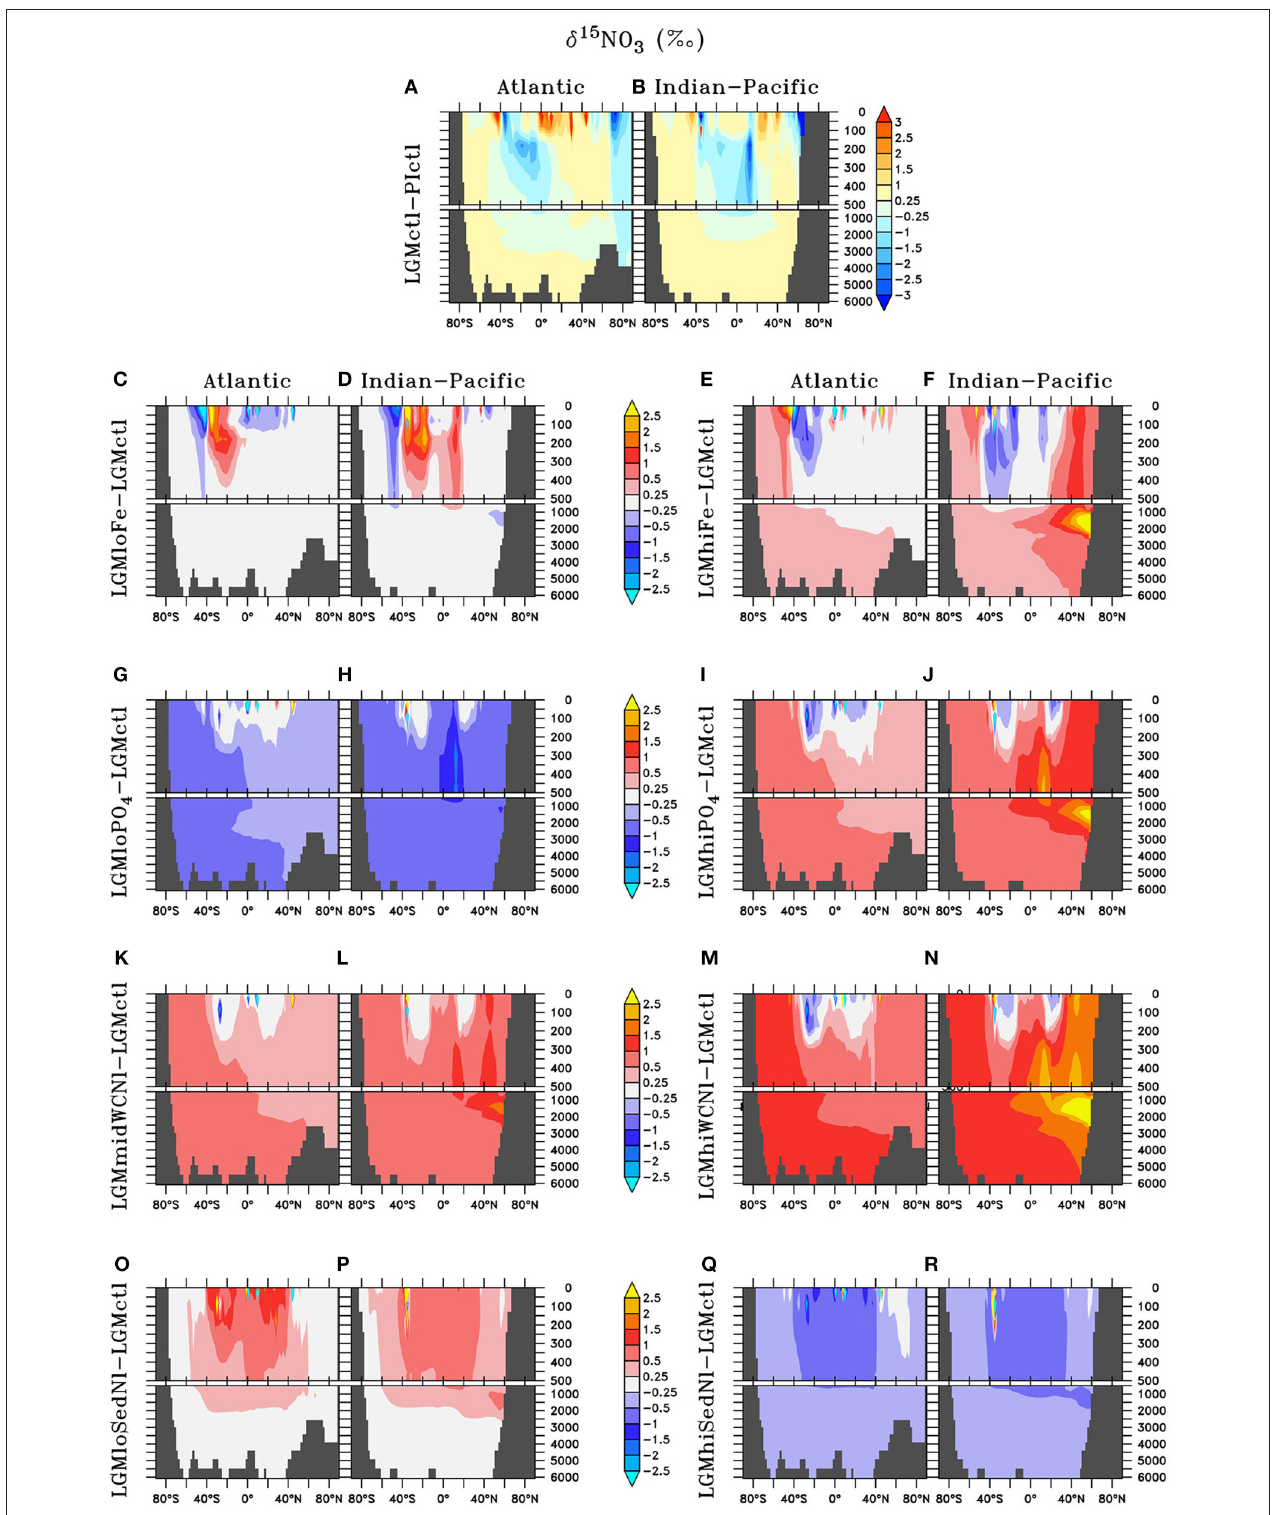
FIGURE 8 | Zonal dissolved δ 15 N of nitrate ( δ 15 NO − 3 ) differences in the Atlantic and Indian-Pacific Oceans, respectively, of (A,B) Last glacial Maximum control (LGMctl) minus preindustrial control (PIctl) and the Last Glacial Maximum simulations minus LGM control: (C,D) LGMloFe, (E,F) LGMhiFe, (G,H) LGMloPO 3 − 4 , (I,J) LGMhiPO 3 − 4 , (K,L) LGMmidWCNl, (M,N) LGMhiWCNl, (O,P) LGMloSedNl, and (Q,R) LGMhiSedNl.